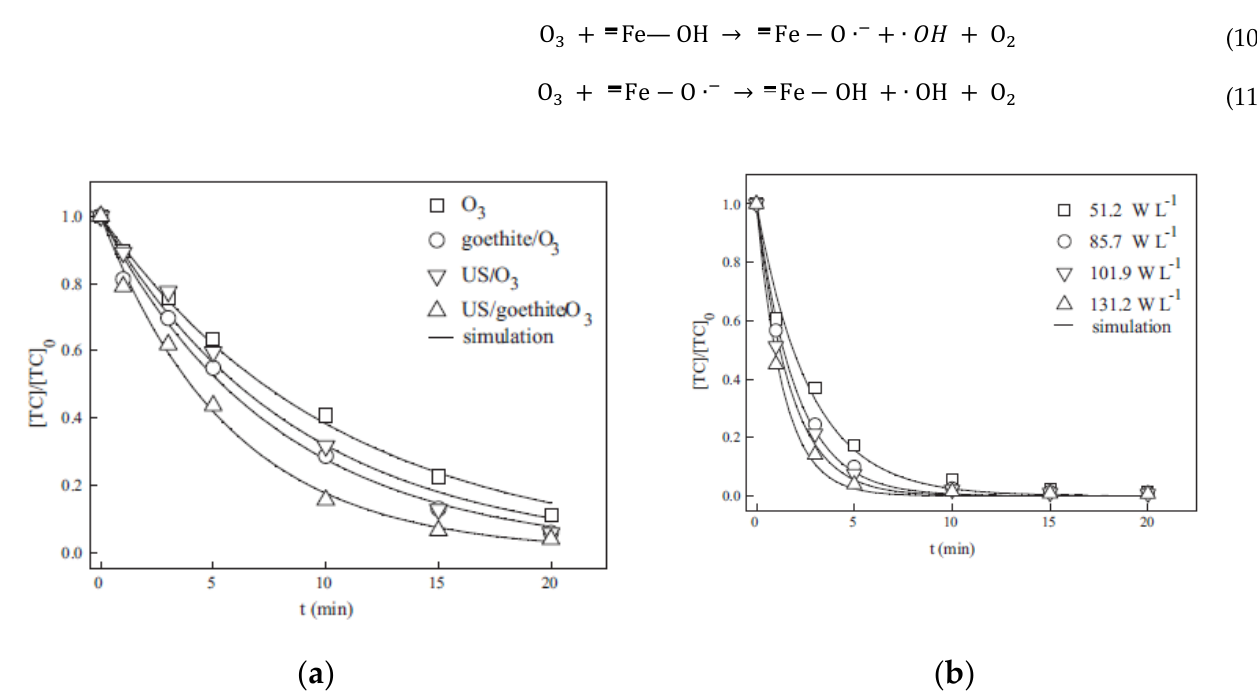
Figure 6. ( a ) Comparative performance for the different oxidation conditions in TC removal; ( b ) effect of US power density